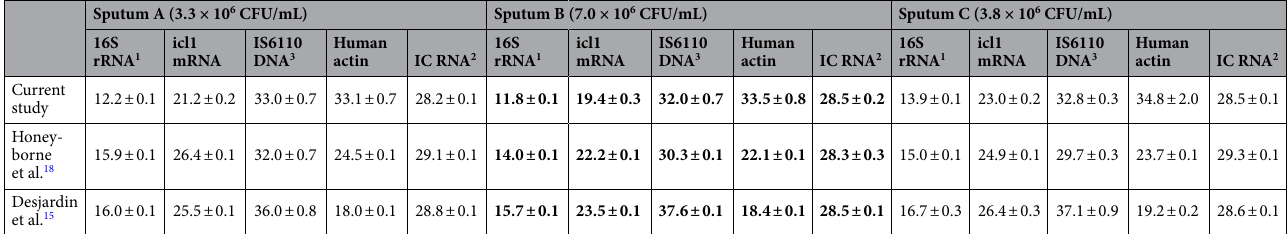
Table 3. Performance of the current RNA extraction protocol in comparison to two previously published methods for purification of Mtb RNA using three TB patient sputum samples. Average cycle threshold values from three replicates are presented for Mtb RNA targets (16S rRNA and icl1 mRNA), one Mtb DNA target (multicopy IS6110), one host target (human actin), and an internal control RNA (IC RNA) which was used to assess percent recovery of RNA and/or presence of qPCR inhibitors. 1 Amplified with primer set F1 “Materials and methods” section). 3 DNase digestion was performed equivalently for all three methods (15 min at 37 °C); CFU, colony forming units. Sputum B columns are bolded for visual aid.